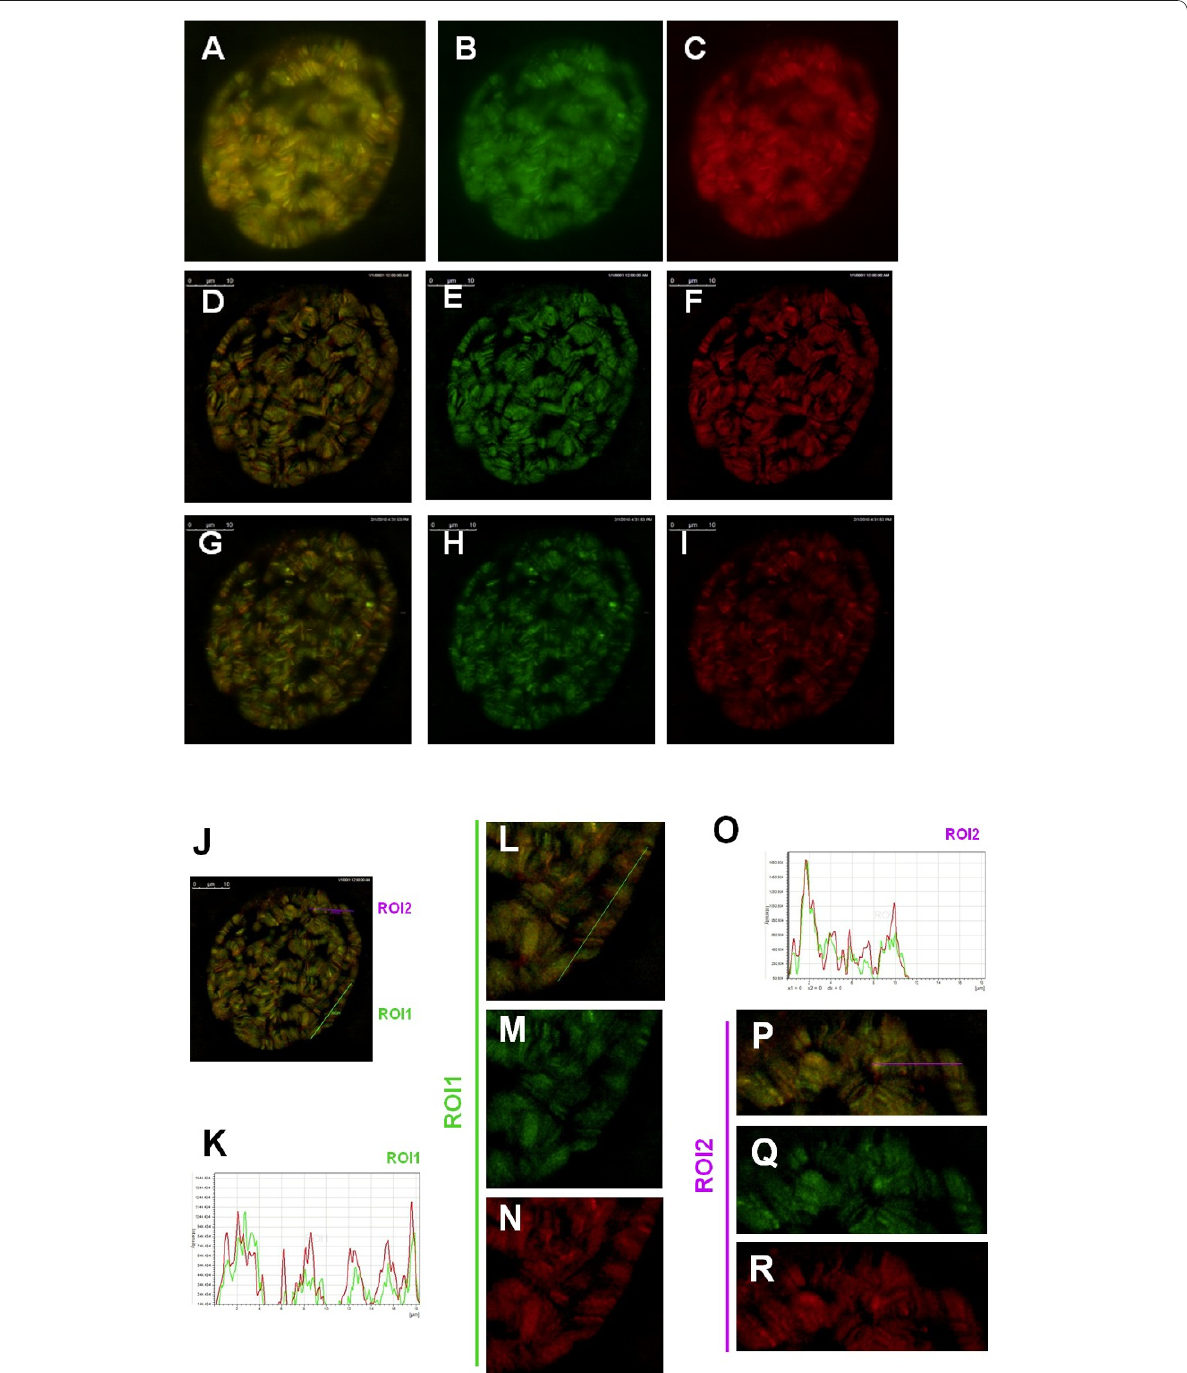
Figure 6 The N-terminal Cp190 fragment containing the BTB domain and D-rich region colocalizes with the full-length Cp190 protein . (A-I) The distribution of the GFP-CP190BTB-D (green, B, E, H, M, Q) and the mRFP-CP190 (red, C, F, I, N, R) proteins in the cell nucleus of a living salivary gland. (D-F) and (G-I) are two of the optical sections from the same cell shown in (A-C) and were analyzed by deconvolusion algorism. The same deconvolusion processed optical section as (D-F) is marked with the ROI1 (green) and ROI2 (purple) (J). (K-R) The intensity profile chart of the ROI1 (K) and the closer views of ROI1 (L-N). The ROI1 is indicated as a green line in (J) and in (L). The Intensity profile chart of the ROI2(O) and the closer views of ROI2 (P-R). The ROI2 is indicated as a purple line in (P) and in